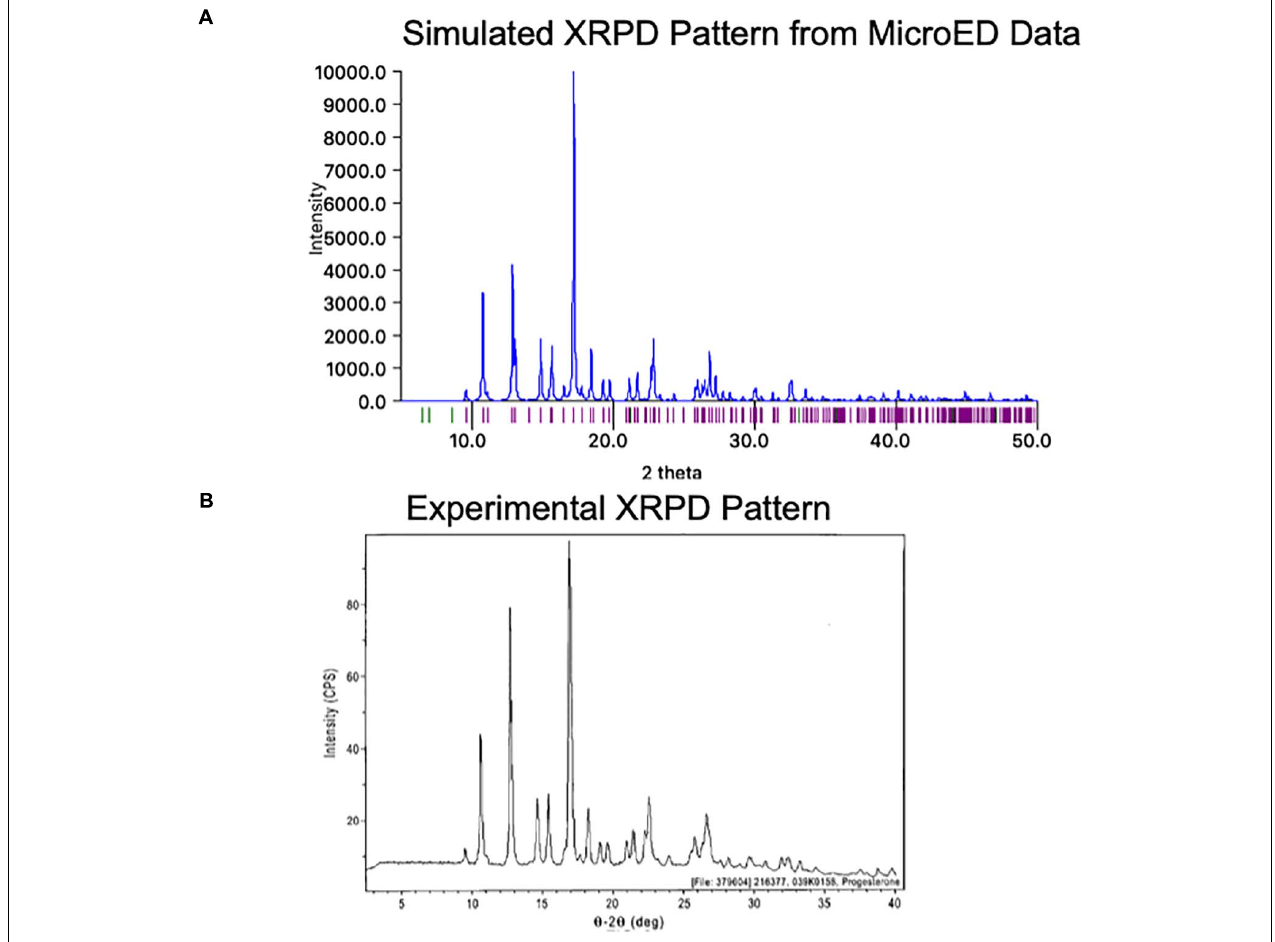
FIGURE 9 | (A) The MicroED structure of progesterone was used to generate a theoretical X-ray powder diffraction (XRPD) pattern at a wavelength of 1.54 Å using Mercury (Macrae et al., 2020). Intensity values are relative to the highest peak. (B) The experimentally measured X-ray powder diffraction (XRPD) pattern for Form I of progesterone is shown roughly lined up to the pattern in panel (A) 4 . We note that some differences may be due to the different temperatures at which each pattern was measured (the MicroED pattern was collected at − 192 ◦ C while the experimental pattern was likely collected at room